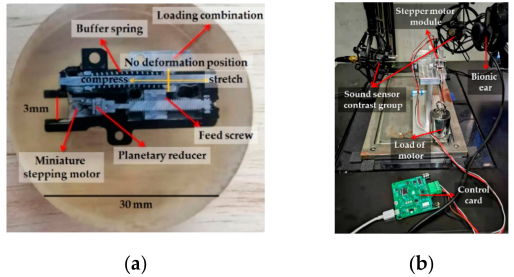
Figure 1. ( a ) Details of stepper motor module; ( b ) acquisition